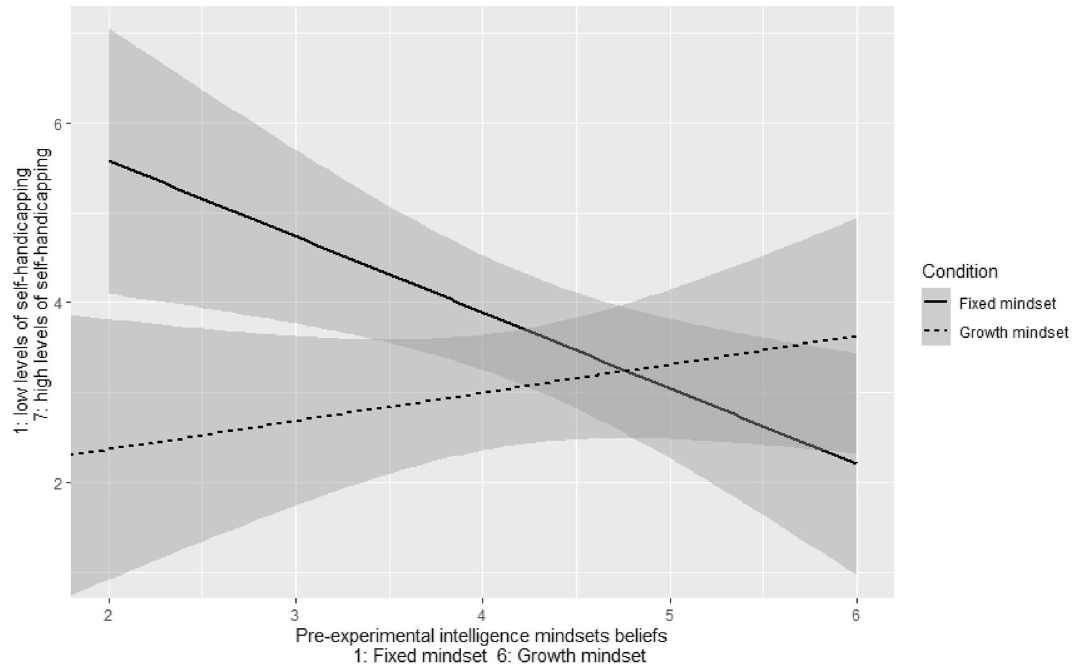
Figure 2. The interaction between prior growth intelligence mindset and intelligence mindset manipulation. The results show that a lower level of prior growth intelligence mindset made participants more vulnerable to behavioral self-handicapping, especially if they met fixed messages of intelligence. Gray shading area represents standard